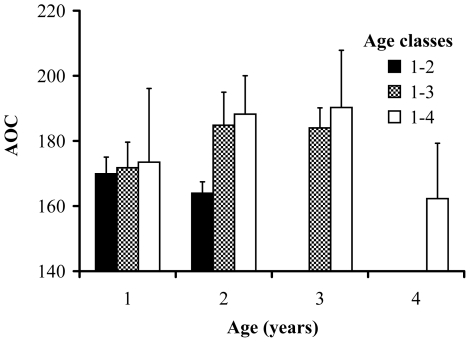
Survival of barn swallows in relation to antioxidant capacity (AOC; mmol l−1 of HClO neutralised).Survival functions were fitted to data stratified according to individuals being of low (< population mean −1 Standard Deviation), intermediate (comprised between mean −1 SD and mean +1 SD), or high (> mean+1 SD) AOC. This analysis differs from that presented in Table 1 and was performed to allow representation of the association between AOC and survival.